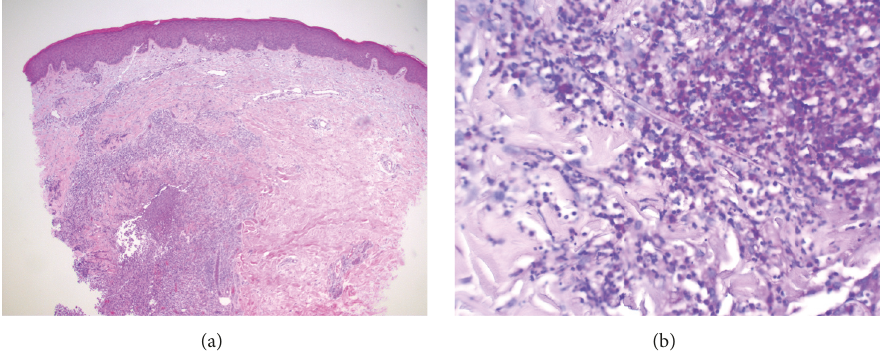
Figure 2: (a) Haematoxylin and eosin stain demonstrating granuloma formation. (b) Periodic acid-Schiff stain demonstrating fungal hyphae.